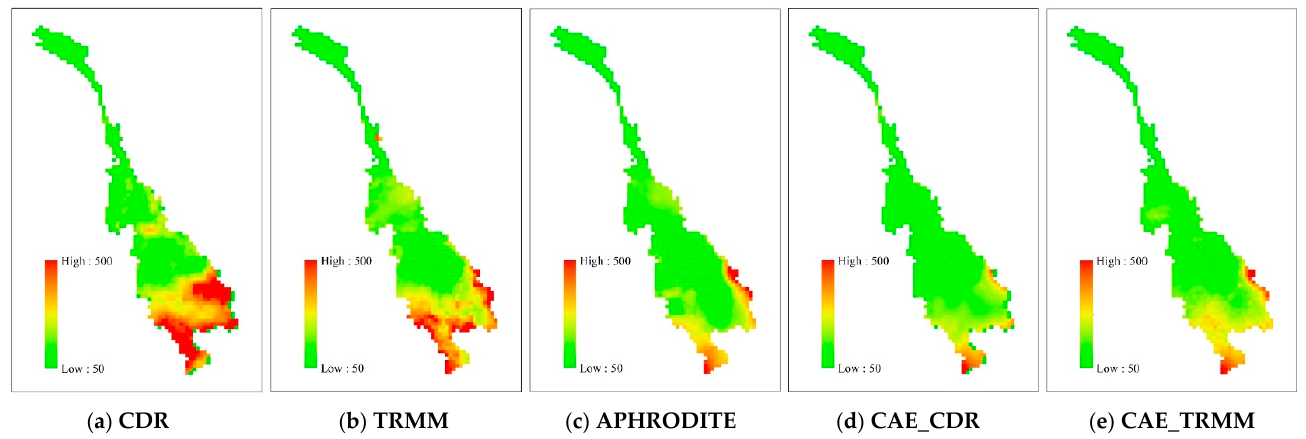
Table 4. Quantitative assessment of seasonal precipitation spatial correlation of products.